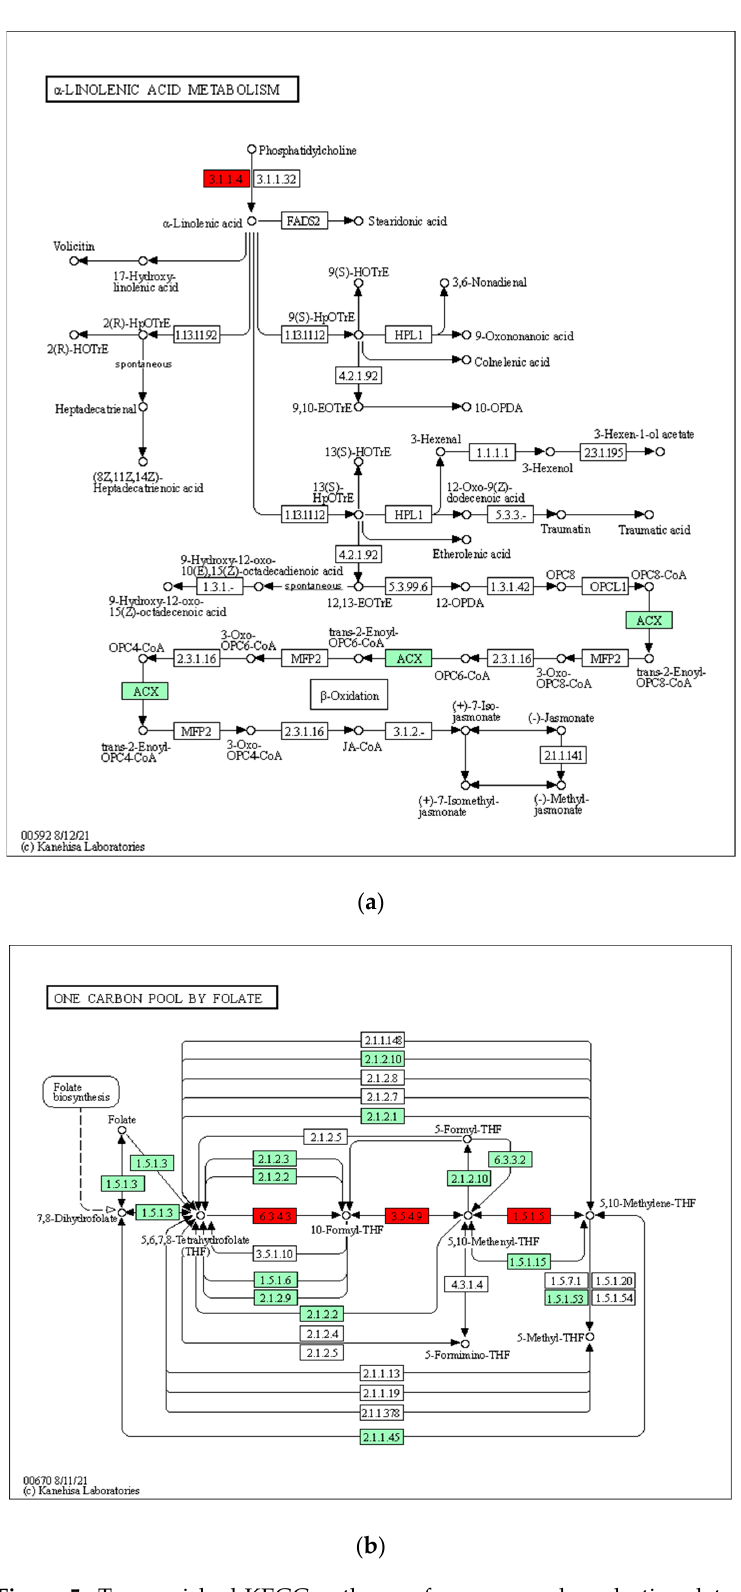
Figure 5. Two enriched KEGG pathways for genes under selection detected in Method 1. Gene numbers with a red background represent genes under selection. Figure ( a ) represents the alpha-linolenic acid metabolism pathway; figure ( b ) represents the one carbon pool by folate pathway.